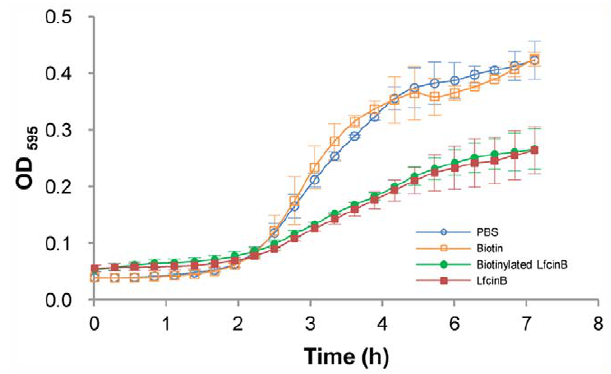
Figure 2. The antibacterial activities of biotinylated LfcinB, LfcinB and biotin. To confirm whether biotinylated LfcinB has different antibacterial activity than unbiotinylated LfcinB, we measured the growth curves of E. coli with each of them. The growth of E. coli with free biotin or with PBS, as a negative control, was also compared. The growth curves of E. coli with biotinylated LfcinB or LfcinB exhibit the same antibacterial activity. E. coli with biotin is similar to the negative